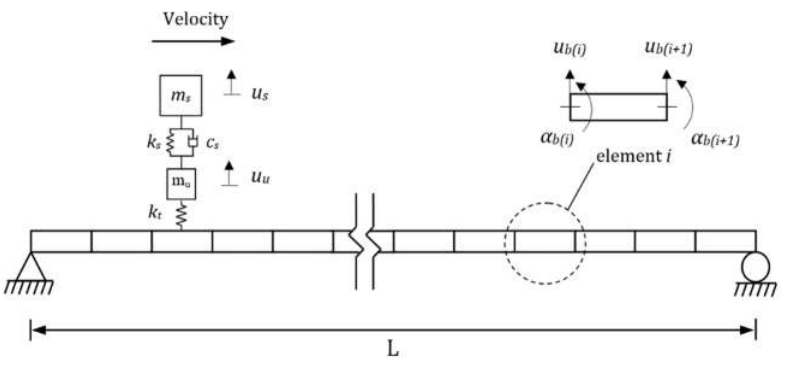
Figure 3. Finite element (FE) model of a quarter-car passing over a bridge.